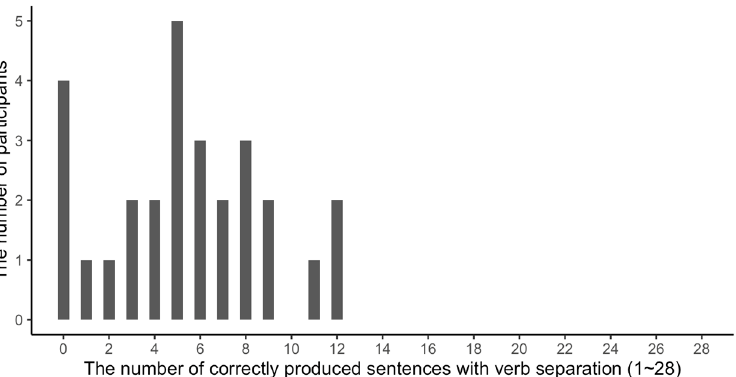
Figure 5. The number of the sentences with separated verbs correctly produced by the participants.